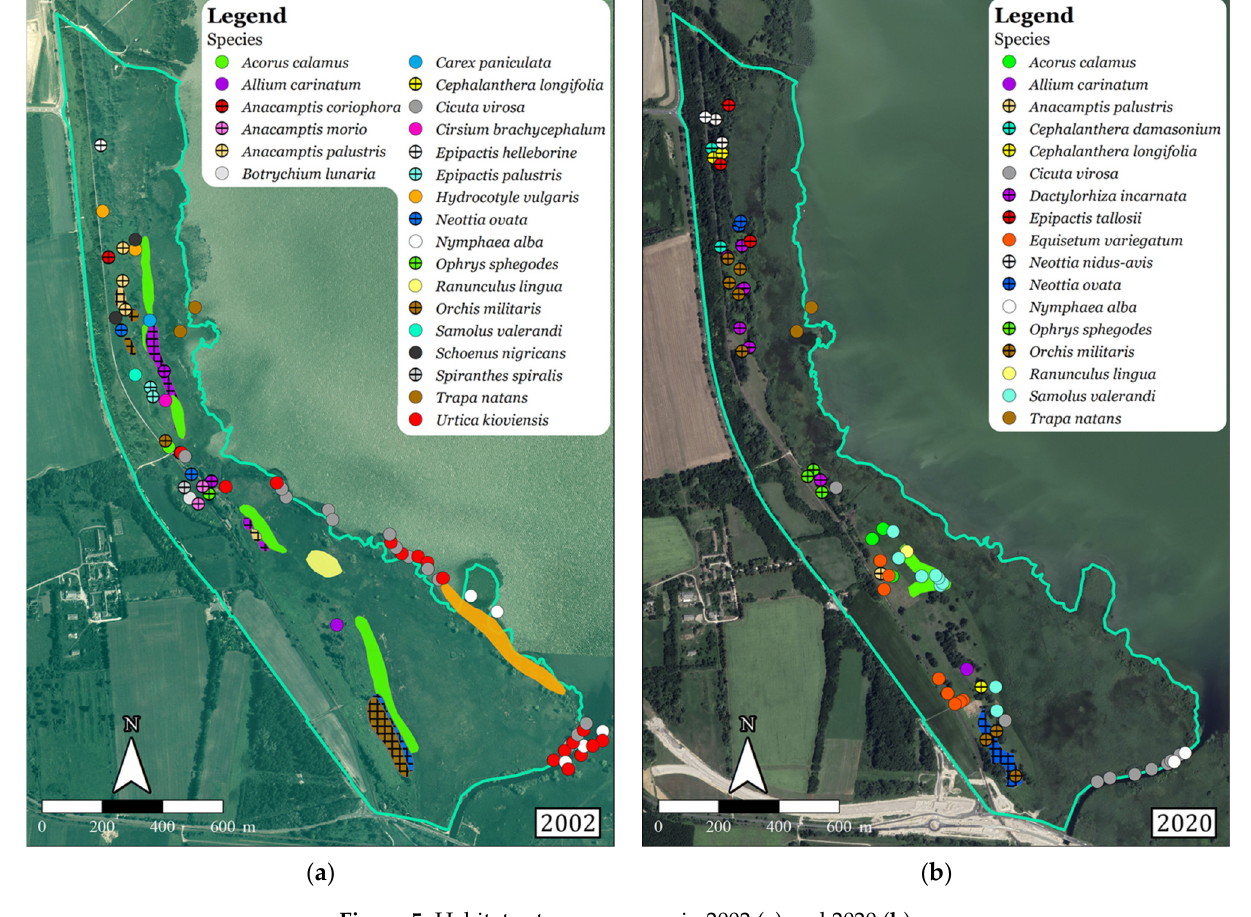
Figure 5. Habitat category groups in 2002 ( a ) and 2020 ( b ). Table 3. The number of localities and individuals of protected plant species in 2002 and 2020. Number of Localities Number of Individuals Species